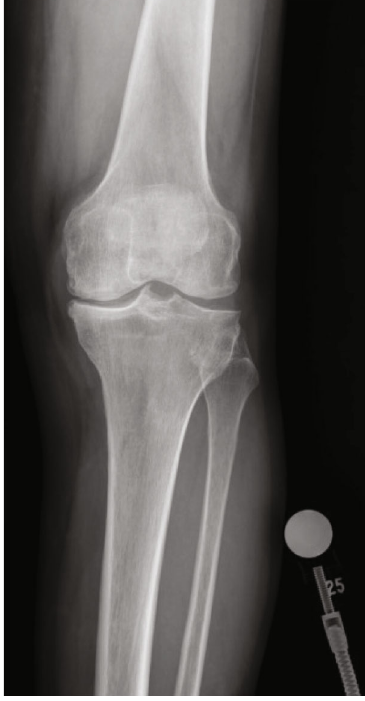
Figure 1: Preop anterior knee X-ray.